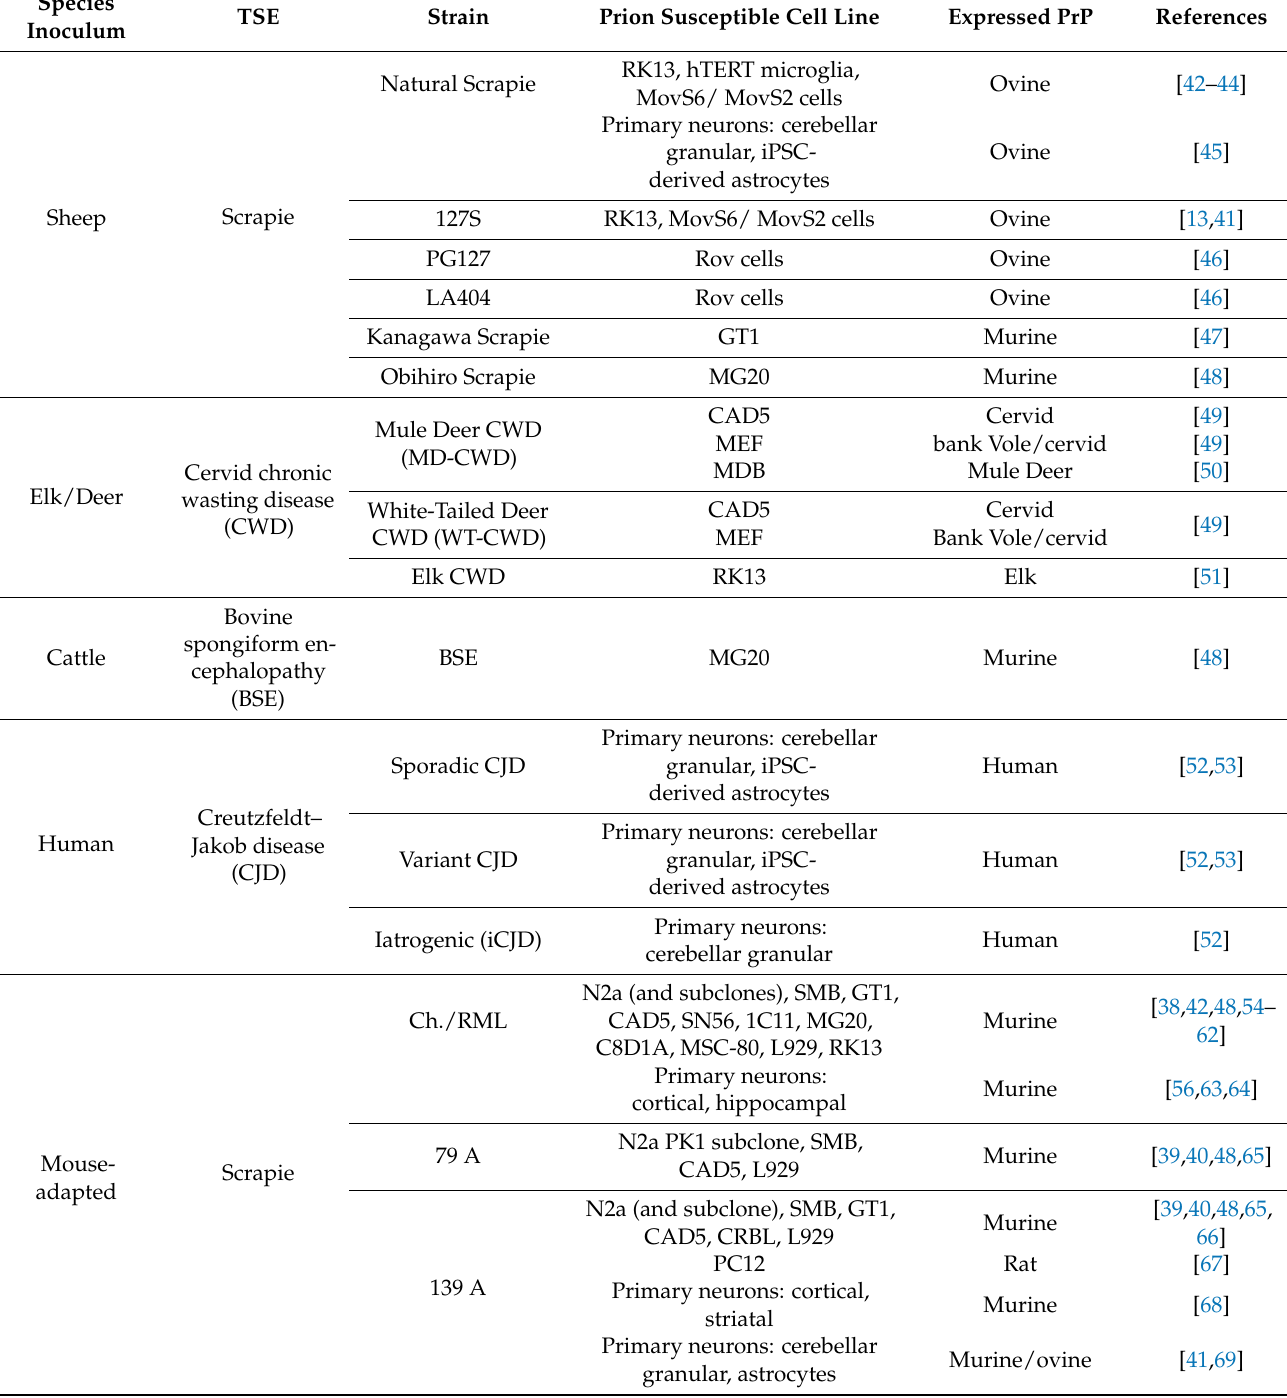
Table 1. Cell lines susceptible to